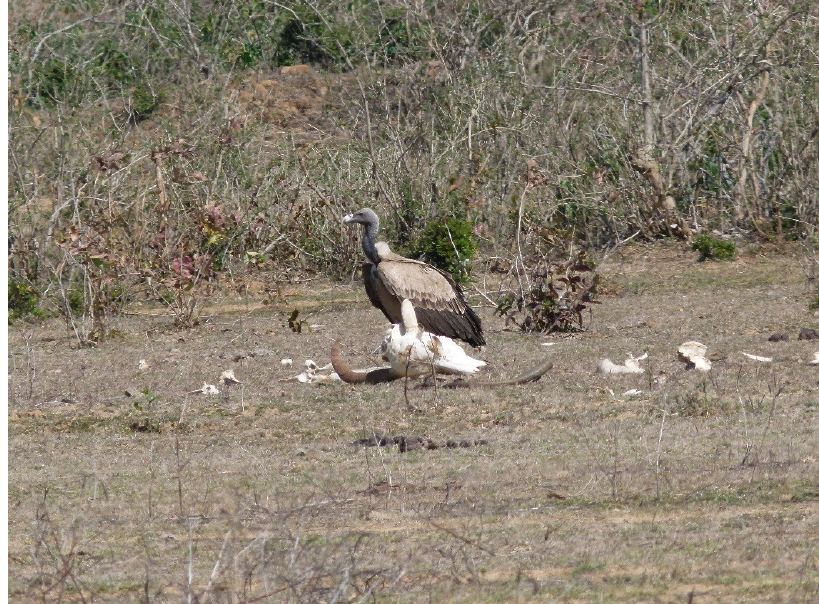
Figure 13. Long-billed or Indian Vulture Gyps indicus revisits a foraging area while roaming in a barren field in search of food. An old cattle carcass skull can be seen in the